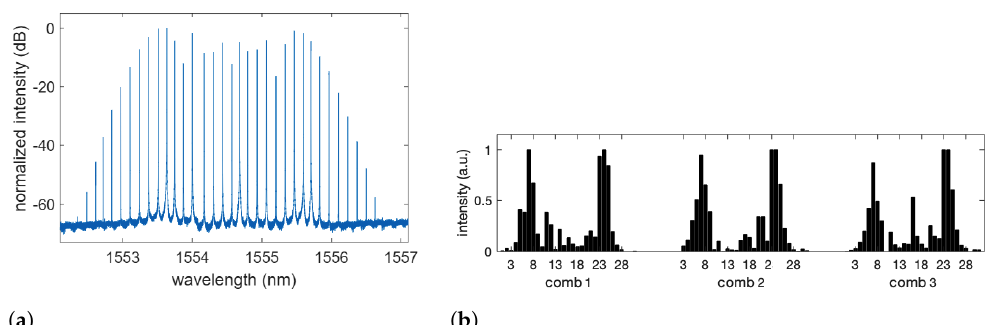
Figure 2. ( a ) Example of spectral comb recorded at the output of PM 1 . For this measurement, a single CW laser source was employed at the wavelength λ = 1554.6 nm. RF modulation was Ω /2 π = 16.99175 GHz, corresponding to a difference in wavelength of approximately 137 pm. The resulting comb has approximately 30 usable lines, which correspond to a bandwidth of approximately 4 nm. ( b ) Example of comb line intensities of the hidden layer, as measured by PD 1 and PD 2 . The task being solved is the mushroom classification in the single operation mode. Three combs are used at the same time, each one comprising 31 comb lines numbered from 1 to